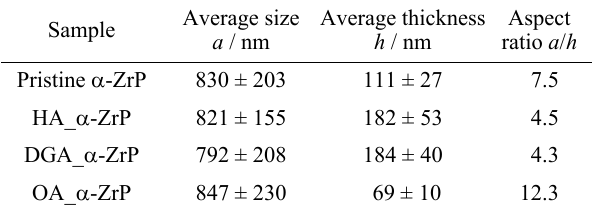
Fig. 2 FESEM images of (a) pristine  -ZrP, (b) HA_  -ZrP, (c) DGA_  -ZrP, and (d) OA_  -ZrP nanosheets. Table 1 Average size and thicknesses of pristine and amine- intercalated  -ZrP nanosheets.